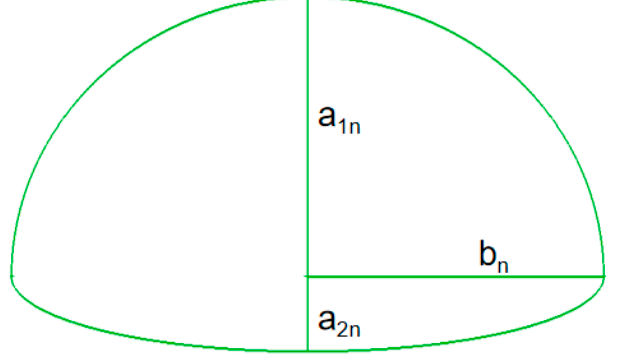
Figure 10. Shape of middle